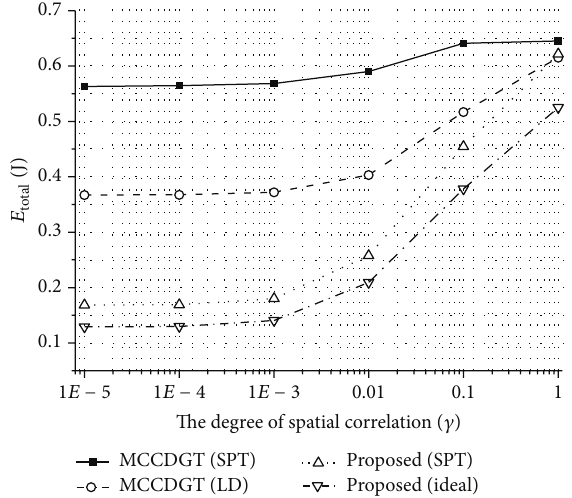
Figure 4: The total energy consumed by sensor nodes to transport all the information derived from one sensing event to the sink node ) for different 𝛾 ( 𝐸 total